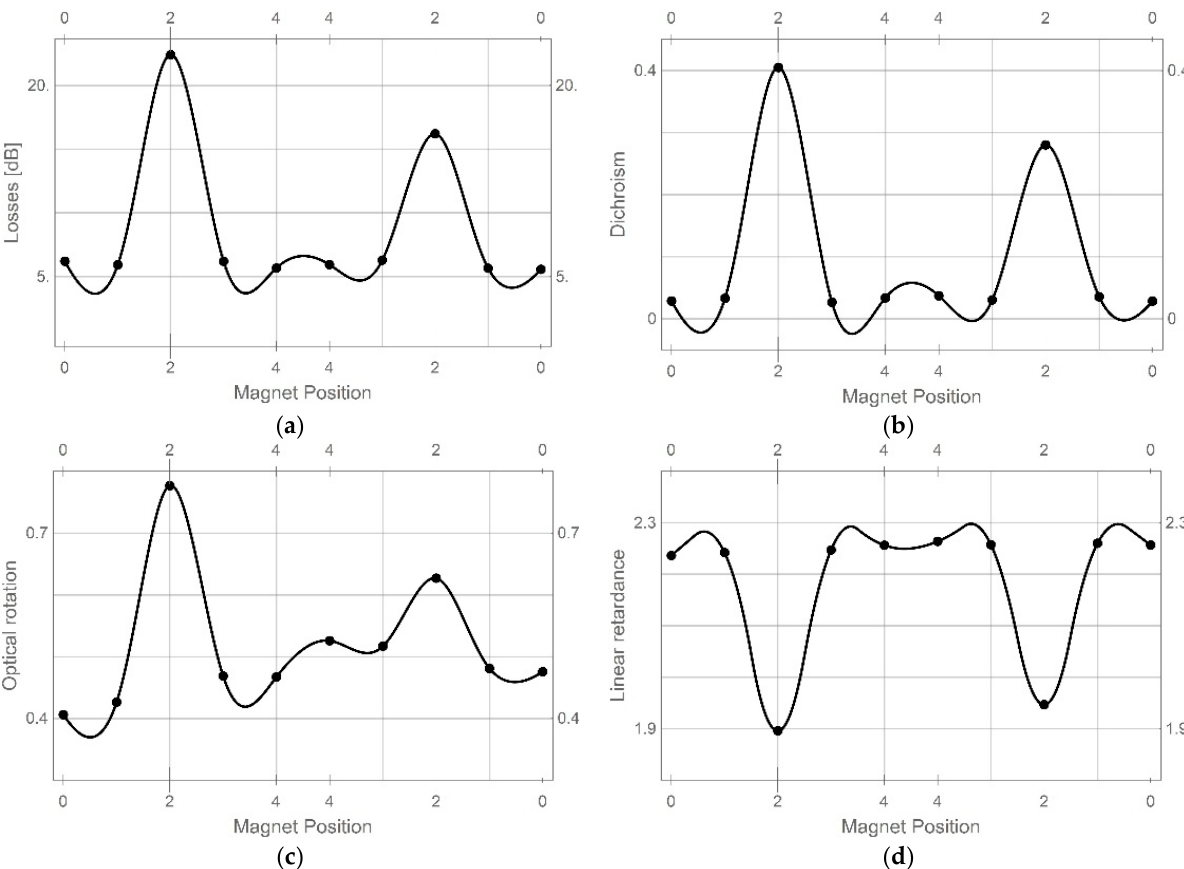
Figure 12. Optical parameters of the tested sensor: ( a ) losses, ( b ) dichroism, ( c ) optical rotation, and ( d ) linear retardance calculated for positions indicated in Figure